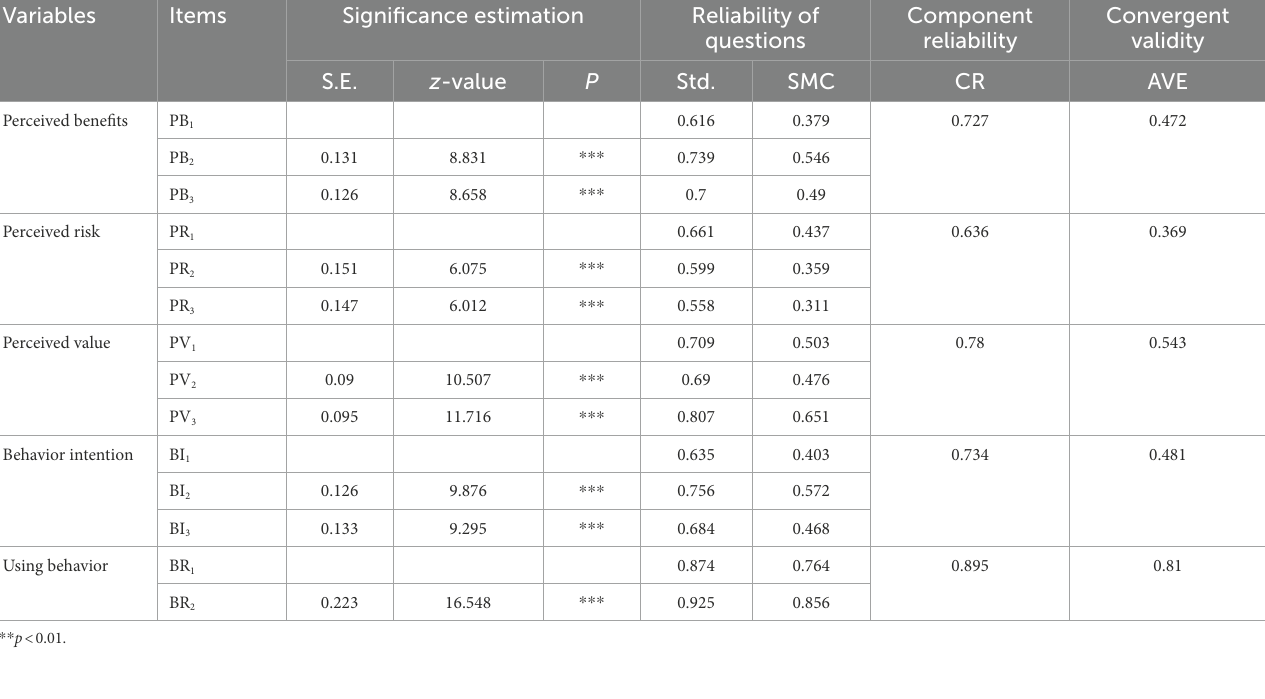
TABLE 4 Fitting results of model